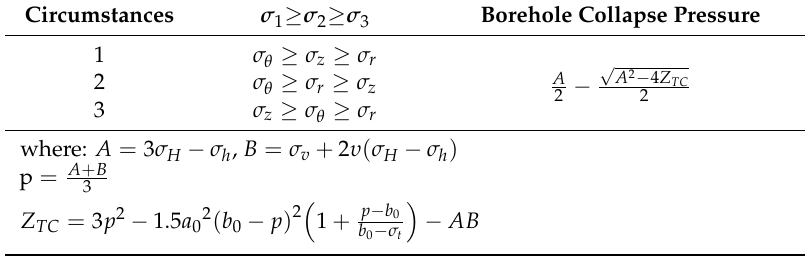
Table 4. Teardrop criterion for the determination of the collapse pressure in an ice